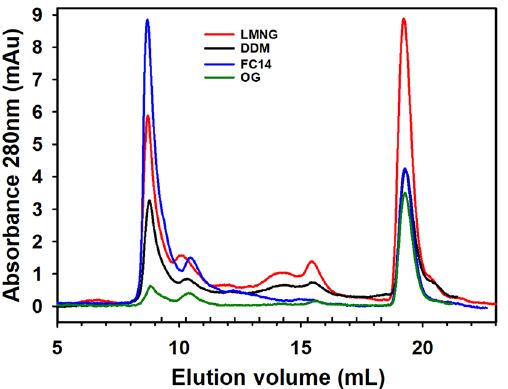
Figure 3. Detergent screen for optimal solubilization and purification of hTAS1R2 expressed in HEK293S cells. Expression of hTAS1R2 was induced with tetracycline (1 µg/mL) and NaBu (5 mM) for 48 h. The hTAS1R2 receptor was solubilized in PBS containing detergent at a concentration of 2% (w/v) for 2 h at 4 °C. After FLAG immunoaffinity purification, the eluate was concentrated to 0.3 mg/mL, loaded on a Superdex 200 3.2/300 column and eluted with PBS containing 0.1% detergent (pH 7.3) at 0.5 mL/min. Purified hTAS1R2 eluted at approximately 13.7 mL. Detergent abbreviations: LMNG, Lauryl maltose neopentyl glycol; DDM, n-Dodecyl-β-